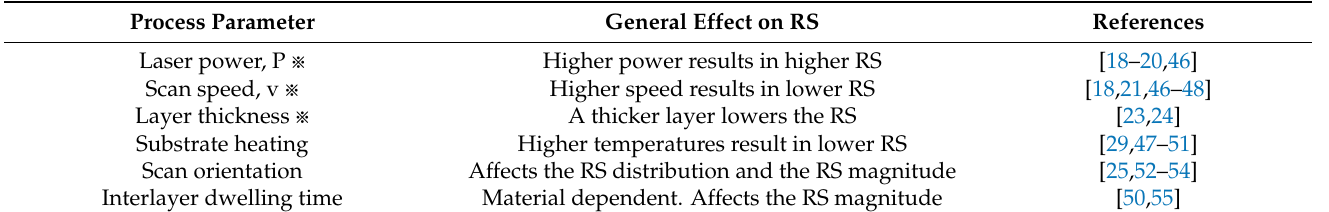
Table 1. A summary of correlations between processing parameters and residual stress formation.